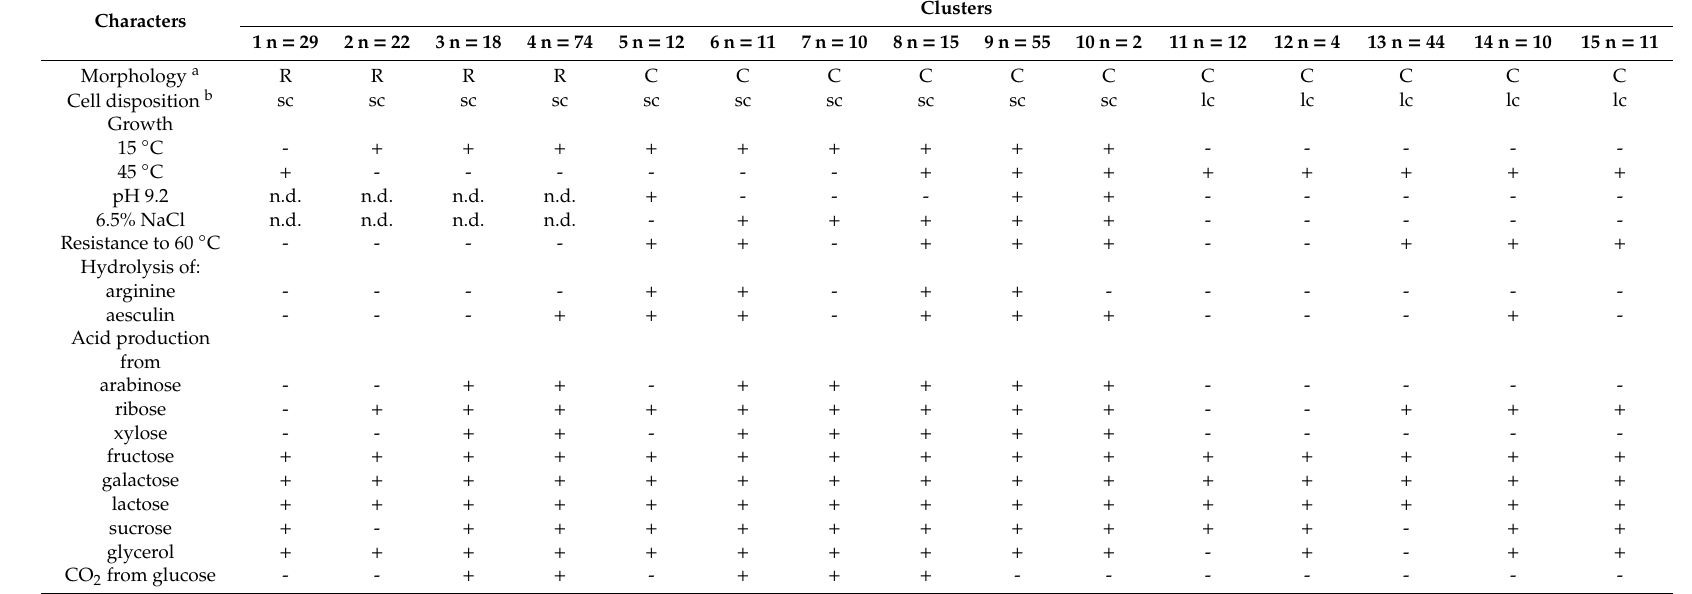
Table 8. Phenotypic grouping of LAB isolated from milk and cheese